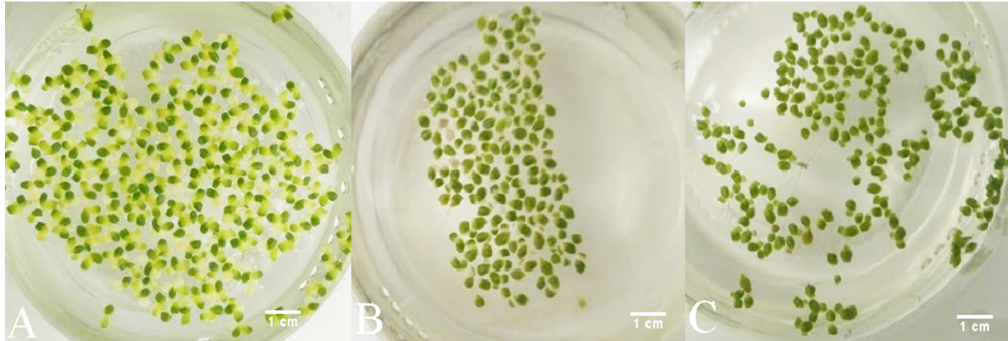
Figure 6. Macroscopic changes of duckweeds at high phenol concentrations: ( A ) at 500 mg L − 1